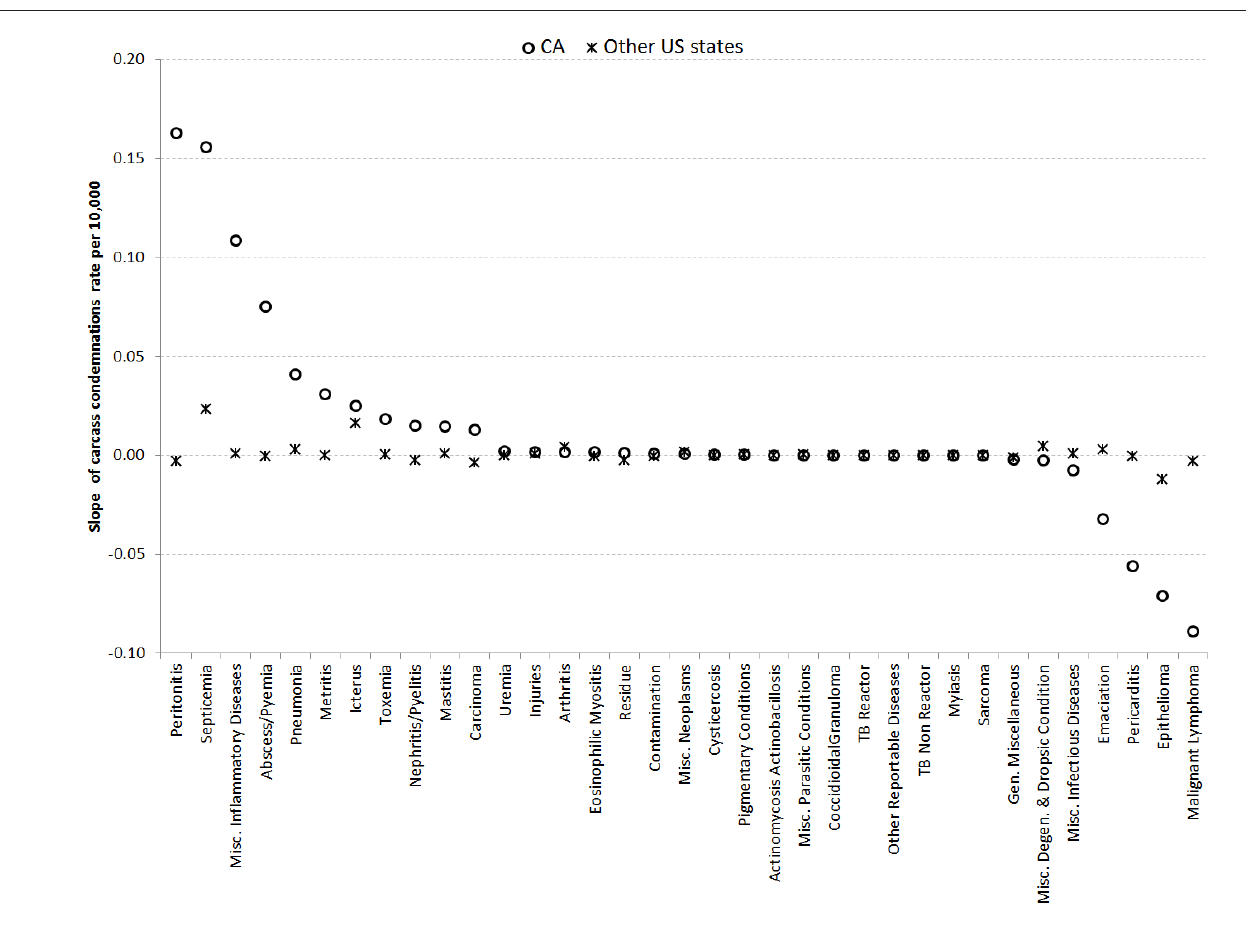
FigUre 4 | Calculated slope (based on integrated random walk model; Equation 5) for the rate of carcass condemnations (number of the condemned carcasses per reason/number of the slaughtered cattle heads) associated with different reasons from Jan-2005 to Dec-2014 in slaughterhouses in California (circle) and other US states (star). A positive calculated slope indicates an increase in the reported rate of carcass condemnations whereas negative slope indicates a decrease in the rate of carcass condemnations in slaughterhouses.